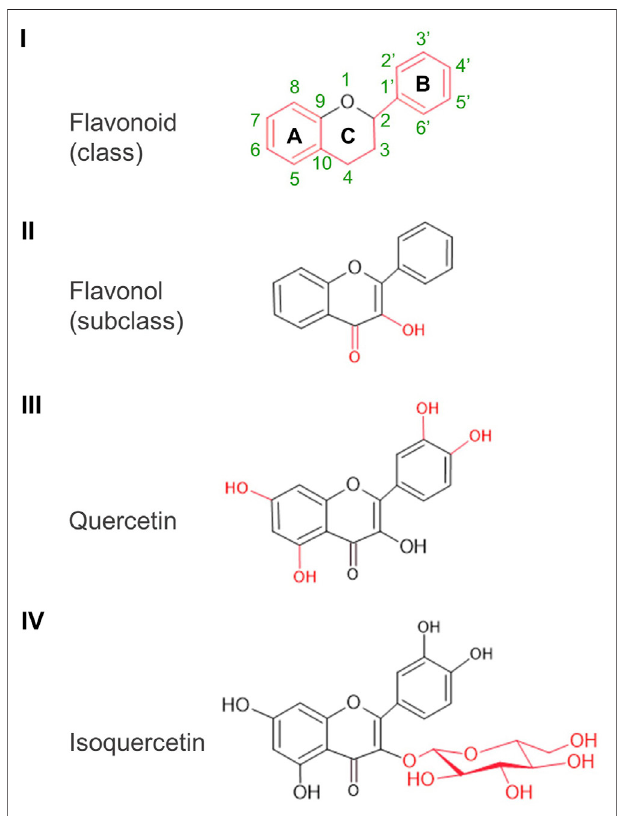
FIGURE 1 | Basic structures: from fl avonoid to isoquercetin. Class, subclass, and particular molecular features are illustrated in red. Atom numbering of the A, B, and C rings indicated for the basic structure of fl avonoids applies to all the other